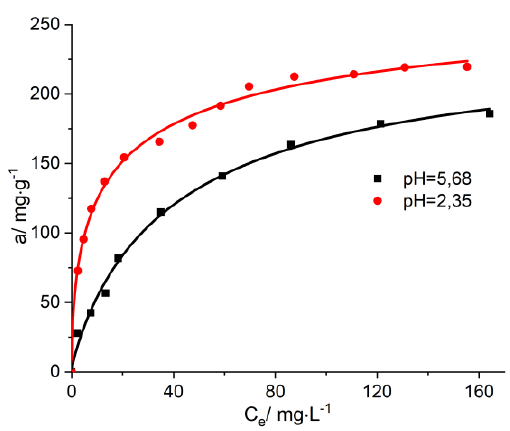
Figure 7. The isotherms of adsorption of vitamin B 12 onto AC-AW-30 for various pH levels.